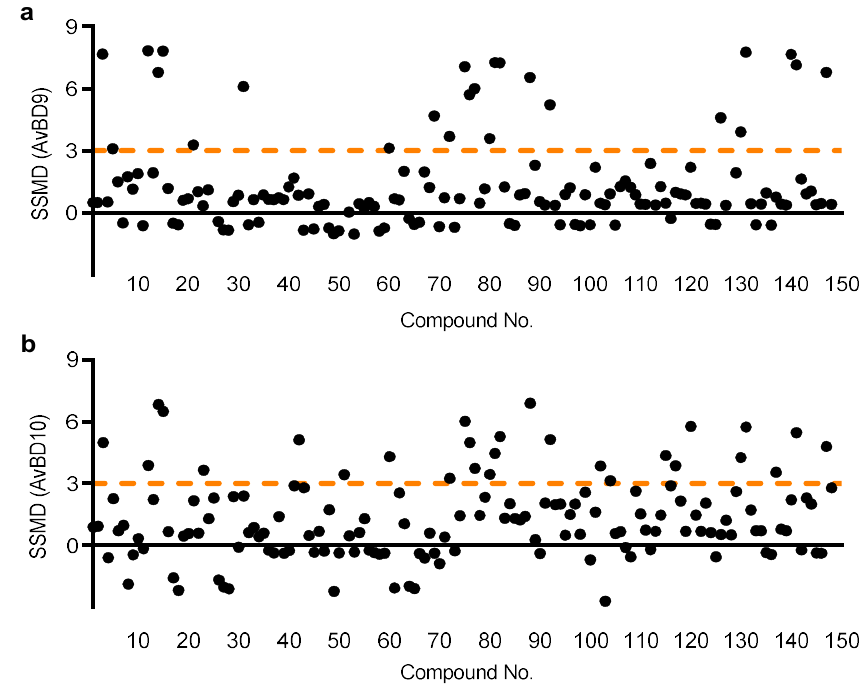
Figure 2. High throughput screening for HDP inducers. Two stable luciferase reporter cell lines, HTC/ AvBD9-luc ( a ) and HTC/ AvBD10-luc ( b ), were employed to screen a library of 148 epigenetic compounds at the final concentration of 20 µM each. Relative luciferase activity was measured following a 24-h exposure and normalized to the cytotoxicity of each compound, followed by calculation of the strictly standardized mean difference (SSMD) value. Those with a minimum SSMD value of 3 were identified as the hits.